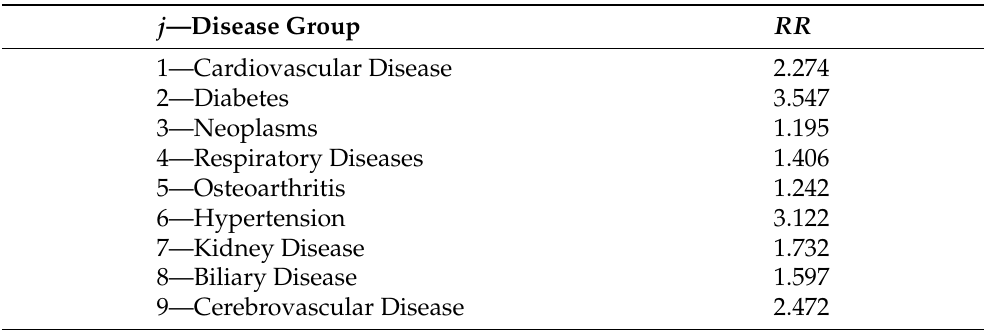
Table 2. The relative risk of a disease with the risk factor of obesity in the disease group j based on Murray et al.